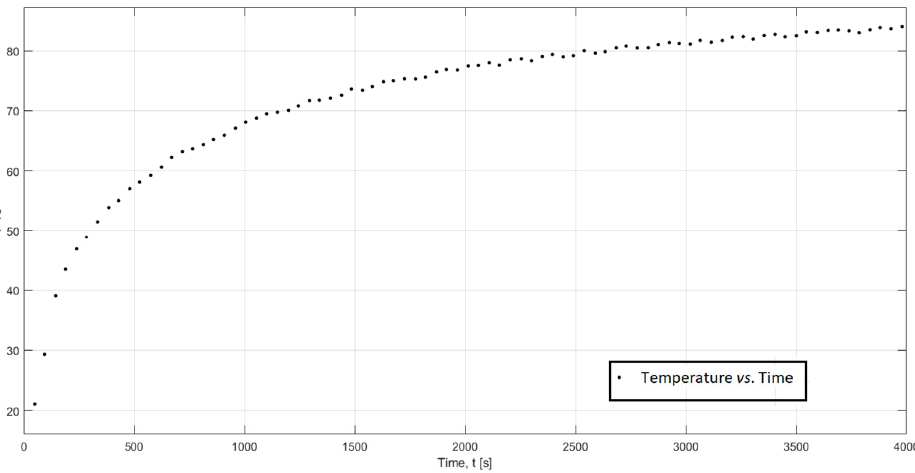
Figure 6. Shotherm QTM-F1 thermal conductivity meter.